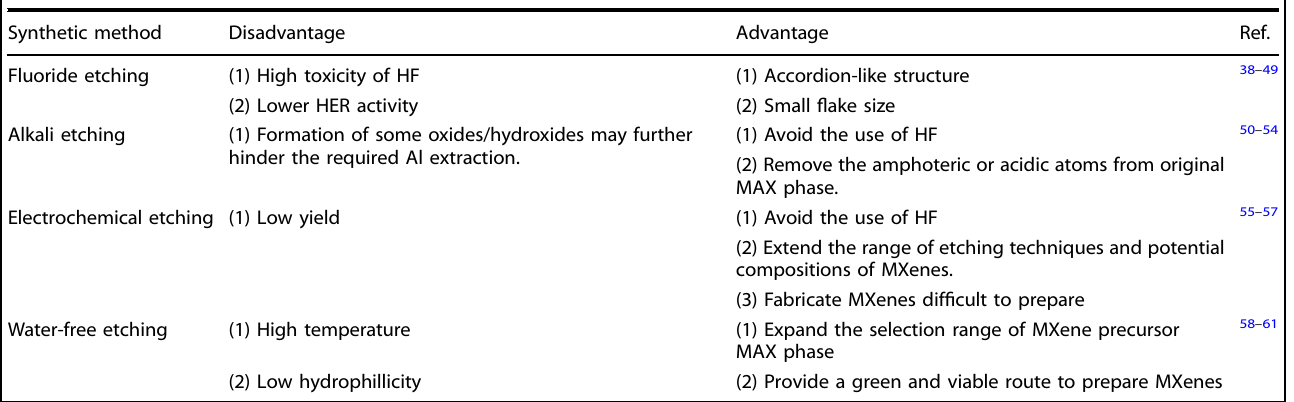
Table 1. The comparisons of etching methods for the synthesis of MXenes. Synthetic